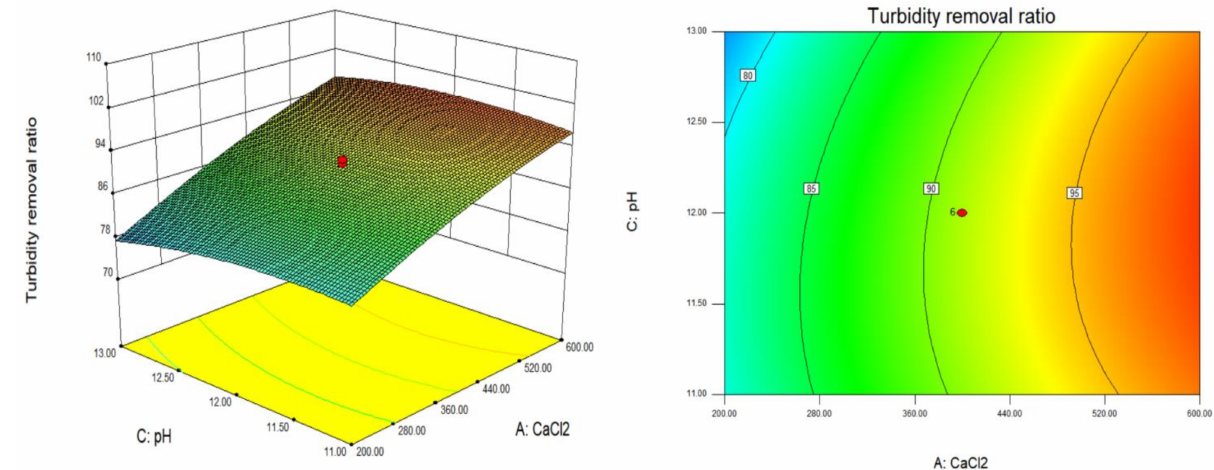
Figure 11. (left) Response surface of the turbidity removal ratio interacted by CaCl 2 dosage and pH value. ( right ) Contour map of the turbidity removal ratio interacted by CaCl 2 dosage and pH value.